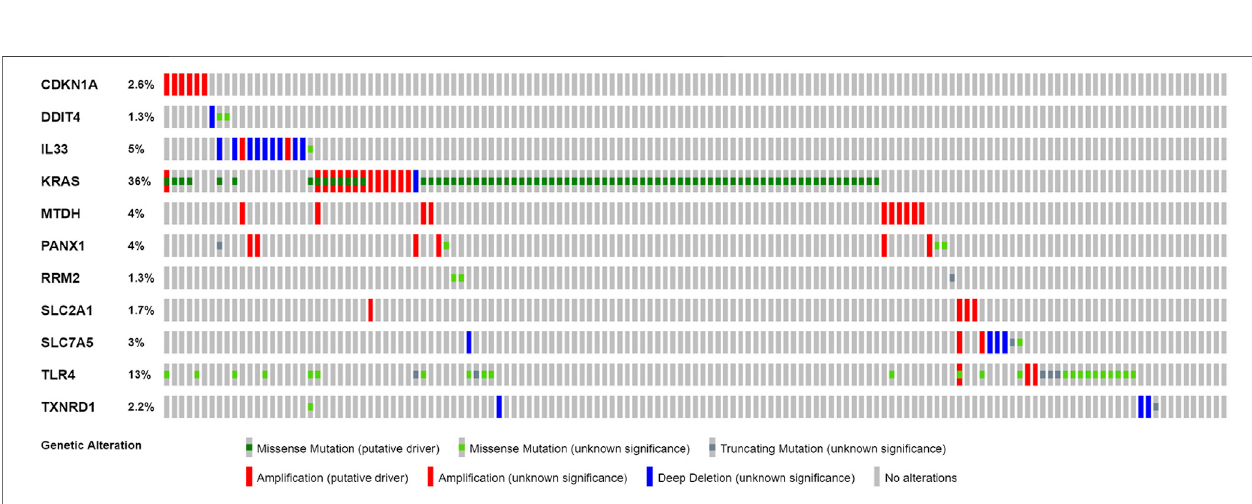
FIGURE 7 | Online database analysis of prognosis ferroptosis-related genes. The total variation frequency of 11 ferroptosis-related genes in LUAD patients.